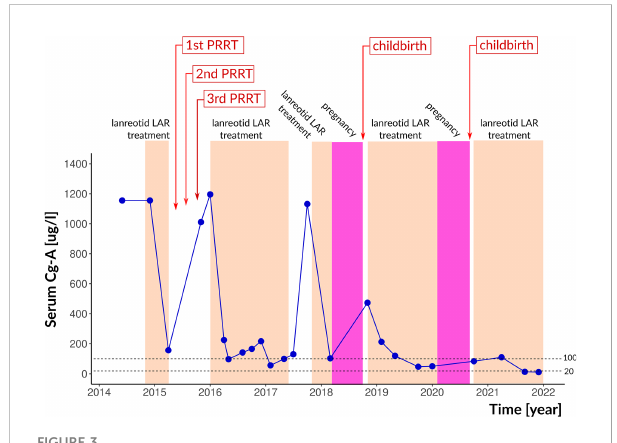
FIGURE 3 Therapeutic interventions, pregnancies and serum chromogranin-A levels. The reference range is indicated by dotted lines. Cg-A,